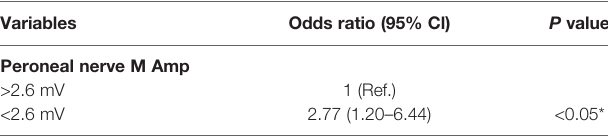
TABLE 3 | Nerve conduction for DCAN in multivariate logistic